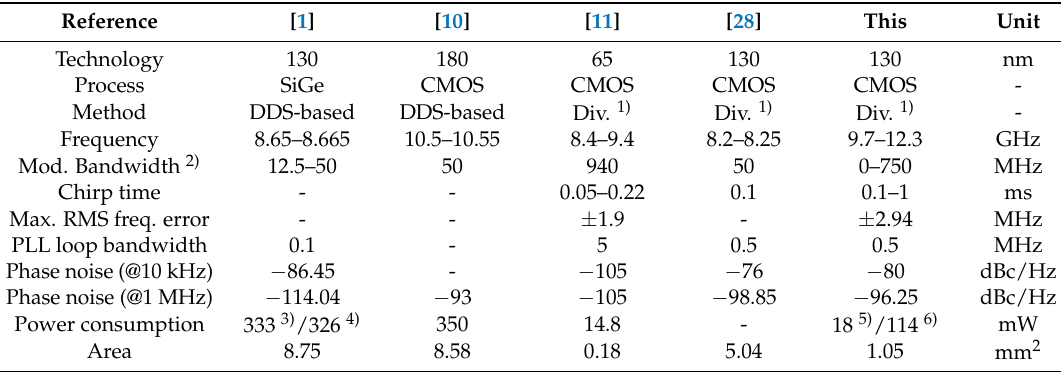
Table 3. Comparison result of previously reported